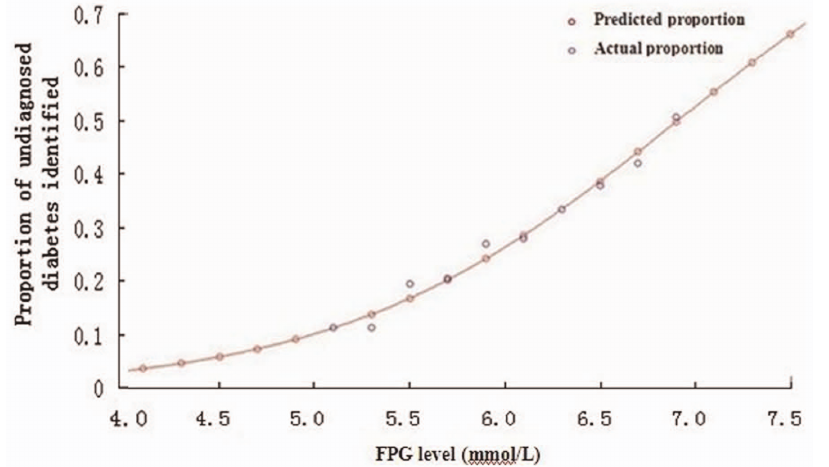
Figure 1. Actual proportion of undiagnosed diabetes identified at different Fasting Plasma Glucose (FPG) levels and its model prediction.